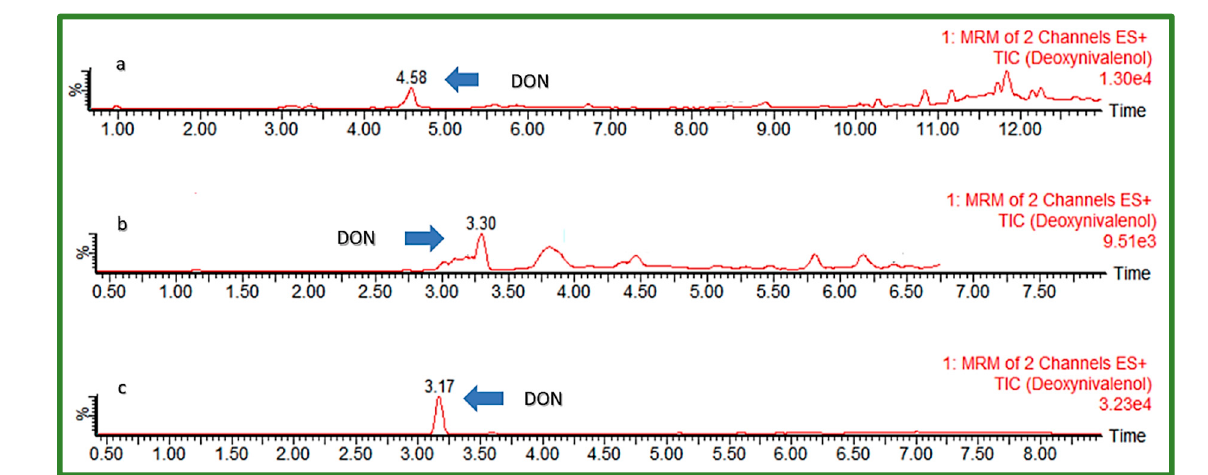
Figure 1. UHPLC-MS/MS chromatogram of early eluting DON (50 ng/mL) using different